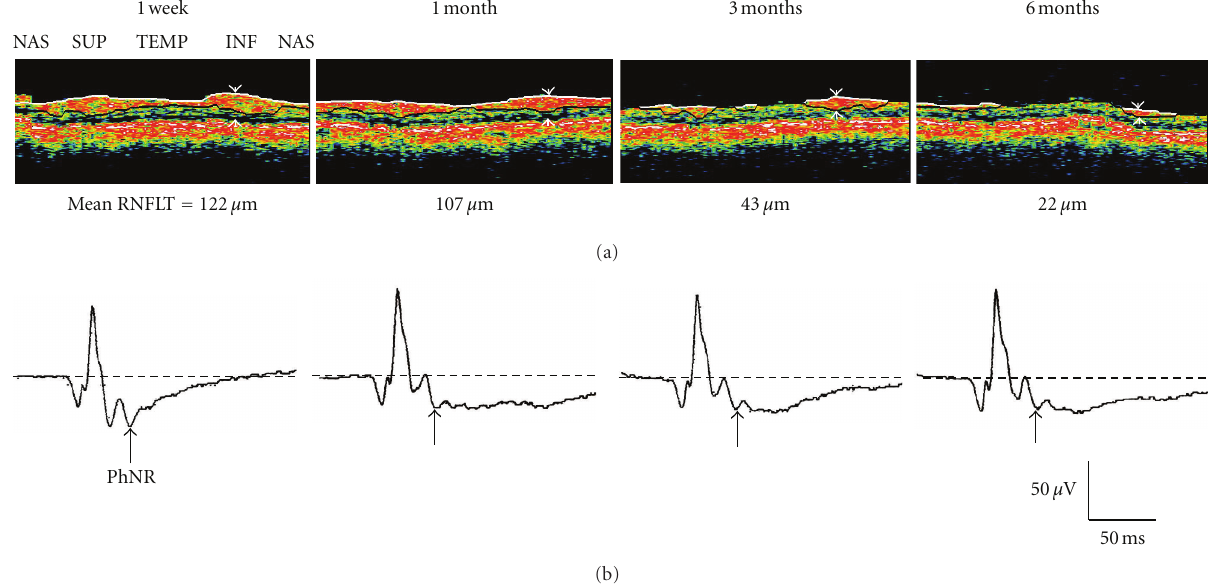
Figure 4: (a) Retinal nerve fiber layer thickness (RNFLT) around the optic nerve head measured by optical coherence tomography in a patient with traumatic optic neuropathy at 1 week and 1, 3, and 6 months after the injury. (b) Cone electroretinograms recorded simultaneously. PhNR: photopic negative response (reproduced with permission from